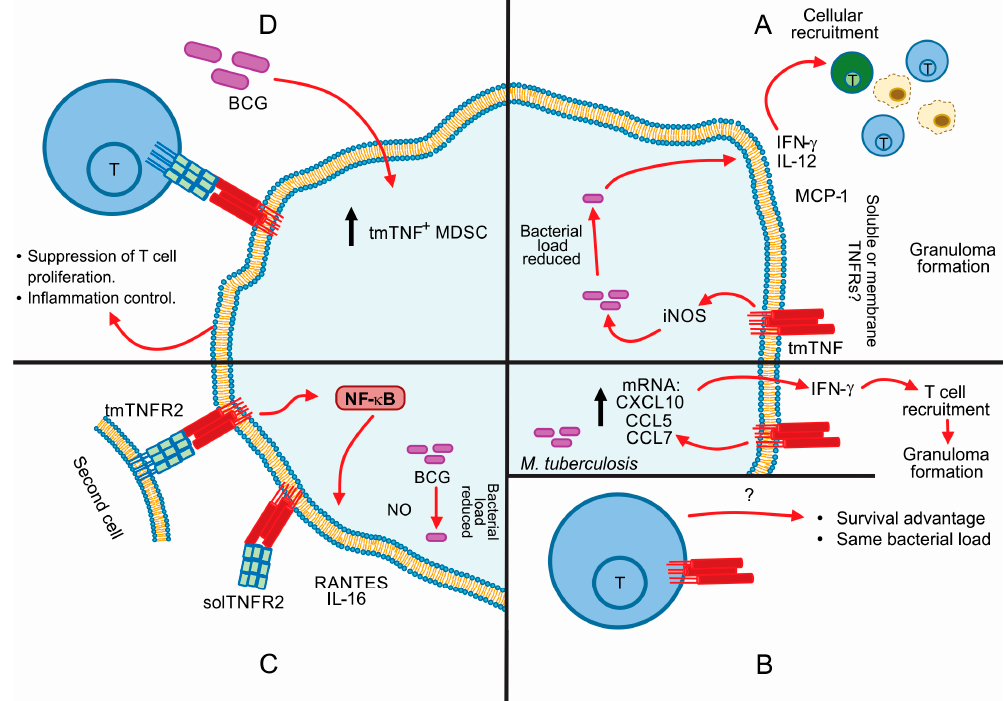
Figure 4. tmTNF in mycobacterial infection. ( A ) tmTNF and iNOS in granulomas promote the secretion of Th1 chemokines and cytokines; ( B ) Up: M. tuberculosis acute-phase infection in mice. Below: tmTNF expression in T cells during M. tuberculosis infection. ( C ) tmTNF regulation by tmTNFR2 or solTNFR2; ( D ) tmTNF expression on MDSC (Myeloid-Derived Suppressor Cells) leads to specific interaction with tmTNFR2. Black arrow up: increased level.